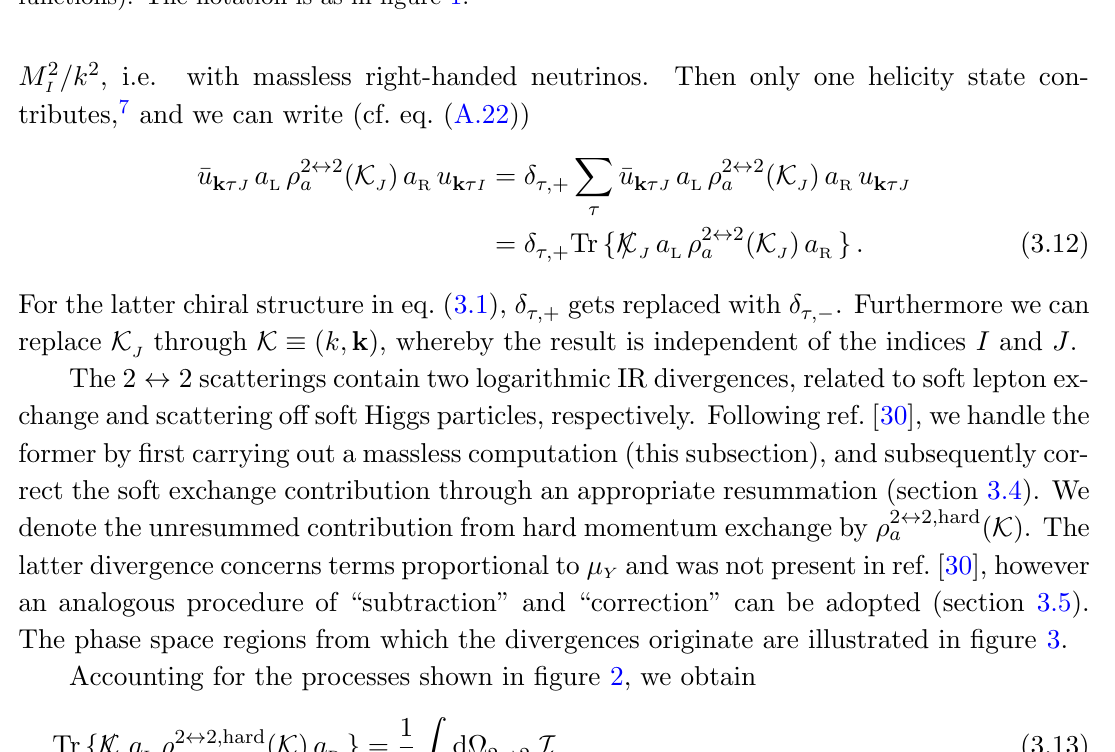
Figure 2 . 2 $ 2 scattering contributions to the sterile neutrino spectral function, cf. eq. (3.13) (the spectral function is a cut, i.e. \amplitude squared", convoluted with the appropriate distribution functions). The notation is as in (cid:12)gure